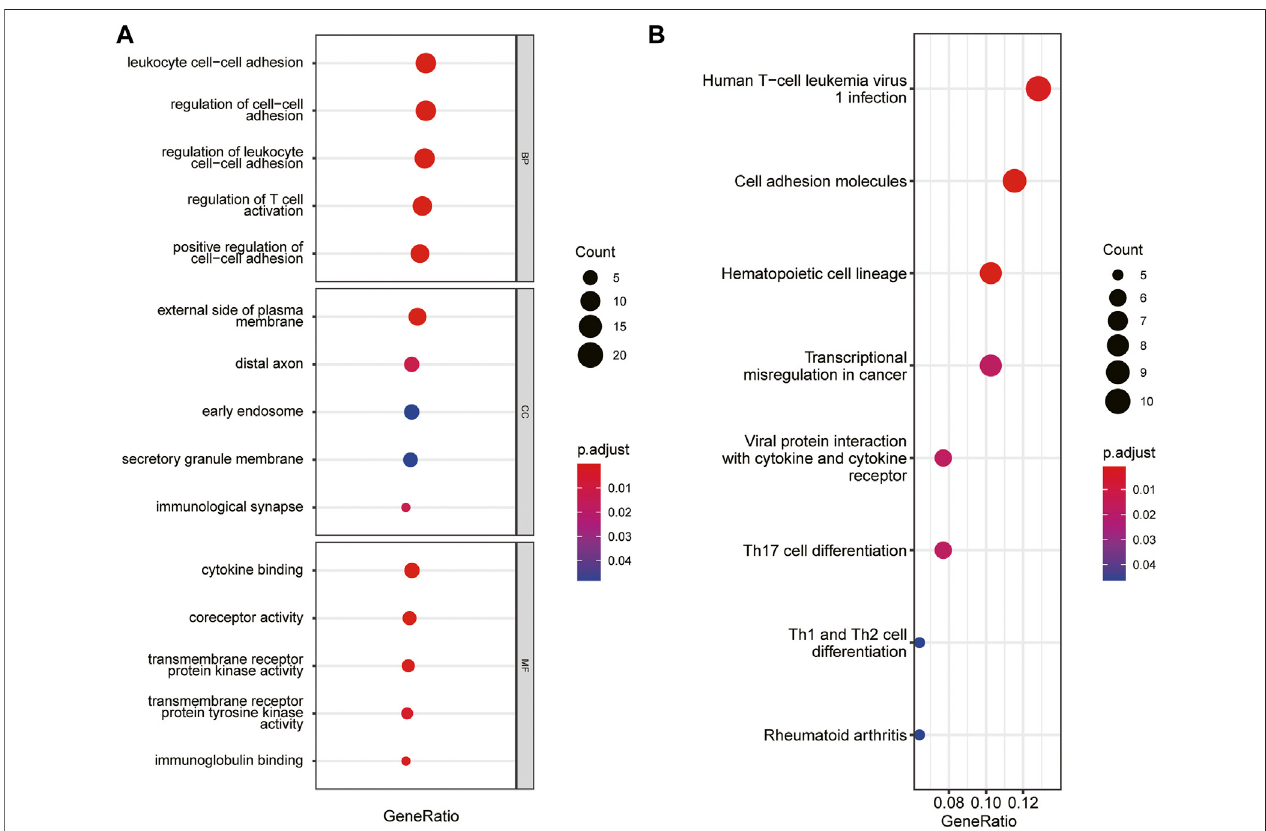
FIGURE 5 | GO and KEGG pathways enrichment analysis of immune-key genes. (A) GO-BP, GO-CC, and GO-MF. (B) KEGG pathway. The color of the bubble represents the p value, and the size of the bubble represents the number of genes.